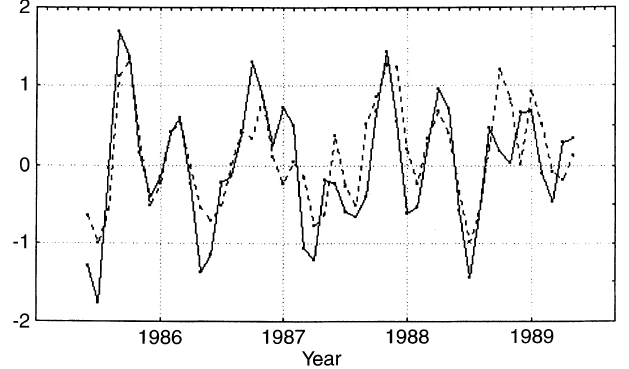
Fig. 6. Predictand pattern from June 1985 to May 1989. Solid line indicates the behaviour of observed data, dashed line indicates the behaviour of the model developed by